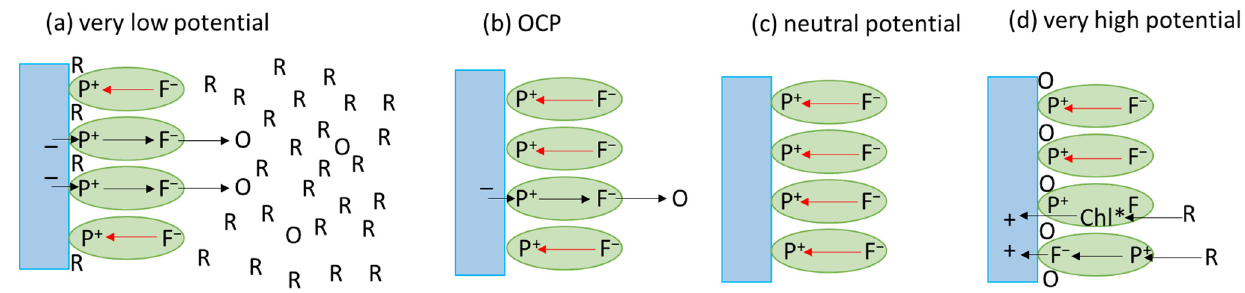
Figure 5. Diagrammatic representation of the ET processes in the PSI-based photoelectrode as a function of the external bias. ( a ) Relatively large cathodic photocurrent due to very low potential applied; ( b ) relatively small cathodic photocurrent at OCP; ( c ) no photocurrent at neutral potential; ( d ) relatively large anodic photocurrent due to a very high potential. Blue rectangles—conducting FTO layer. Green ovals—PSI particles. O and R—oxidized and reduced forms of redox compounds in the electrolyte. Excess of R over O forms in panel ( a ) illustrates the real effect of reduced species domination in bulk electrolyte solution. Black arrows—forward ET, red arrows—back ET. Chl* — photoexcited antenna Chls. F—one of the PSI electron acceptors. Note that, for simplicity, only homogeneous orientation of the PSI particles is depicted.